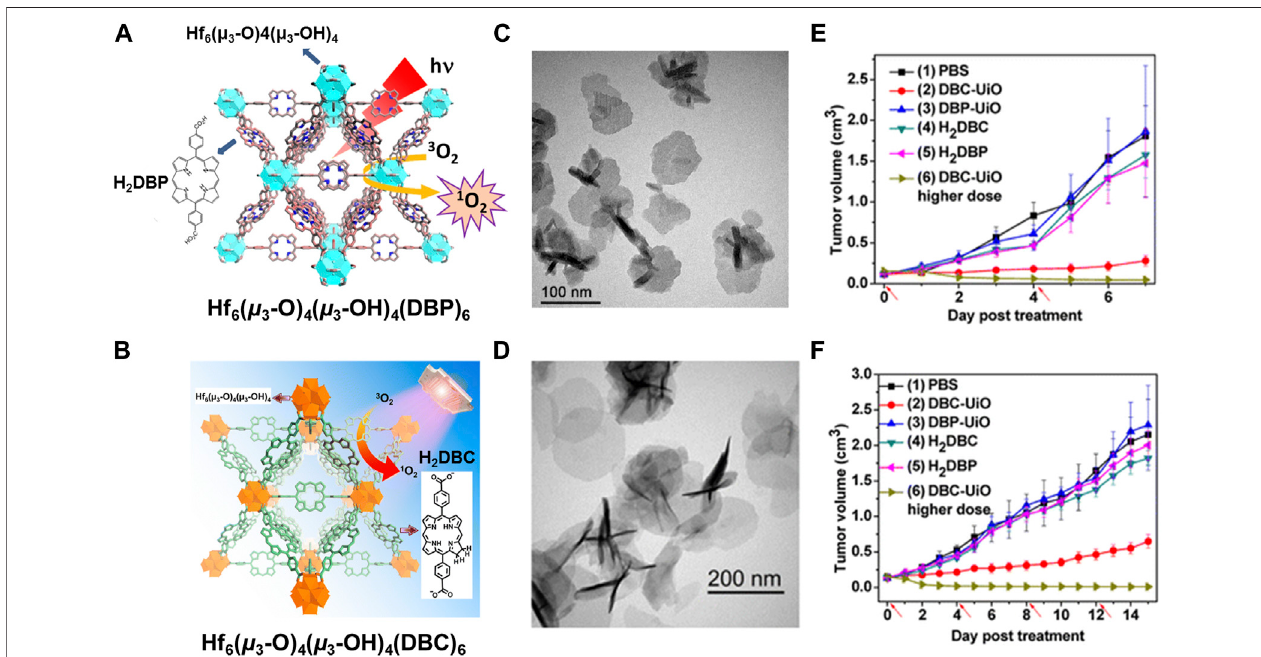
FIGURE 6 | (A) The structure of Hf − DBP NMOF and the schematic description of 1 O 2 generation process. (B) The structure of Hf − DBC NMOF and the schematic description of 1 O 2 generation process. (C) TEM image of DBP − UiO with nanoplate morphology. (D) TEM image of DBC − UiO with nanoplate morphology. In vivo PDT ef fi cacy on CT26 and HT29 tumor-bearing mice: (E) Tumor growth inhibition curve after PDT treatment by DBP − UiO. (F) Tumor growth inhibition curve after PDT treatment by DBC − UiO. Source: (Lu et al., 2014; Lu et al., 2015).